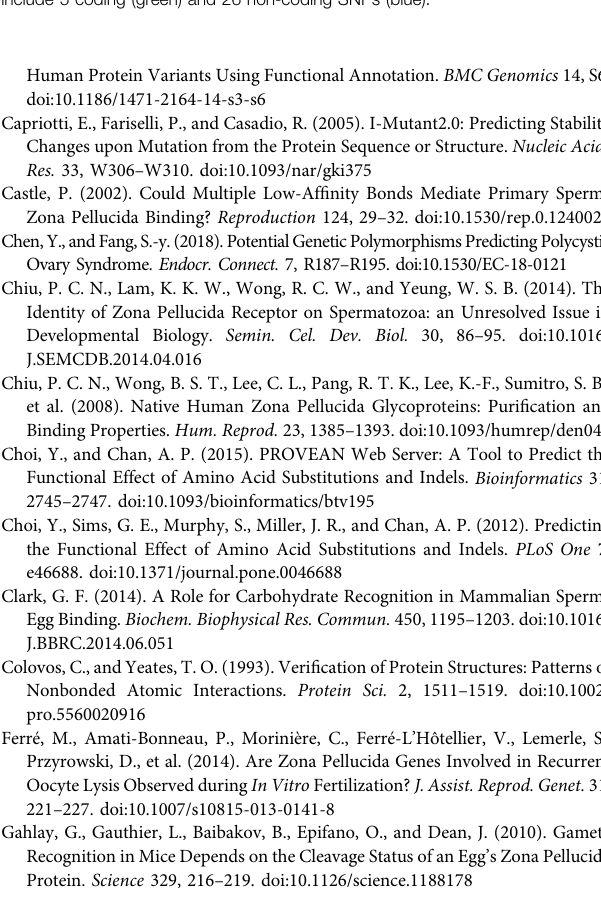
Supplementary Figure 1 | A graphical representation of global MAF values of 31 SNPs predicted to effect the regulation of hZP2 by FuncPred. These 31 SNPs include 5 coding (green) and 26 non-coding SNPs